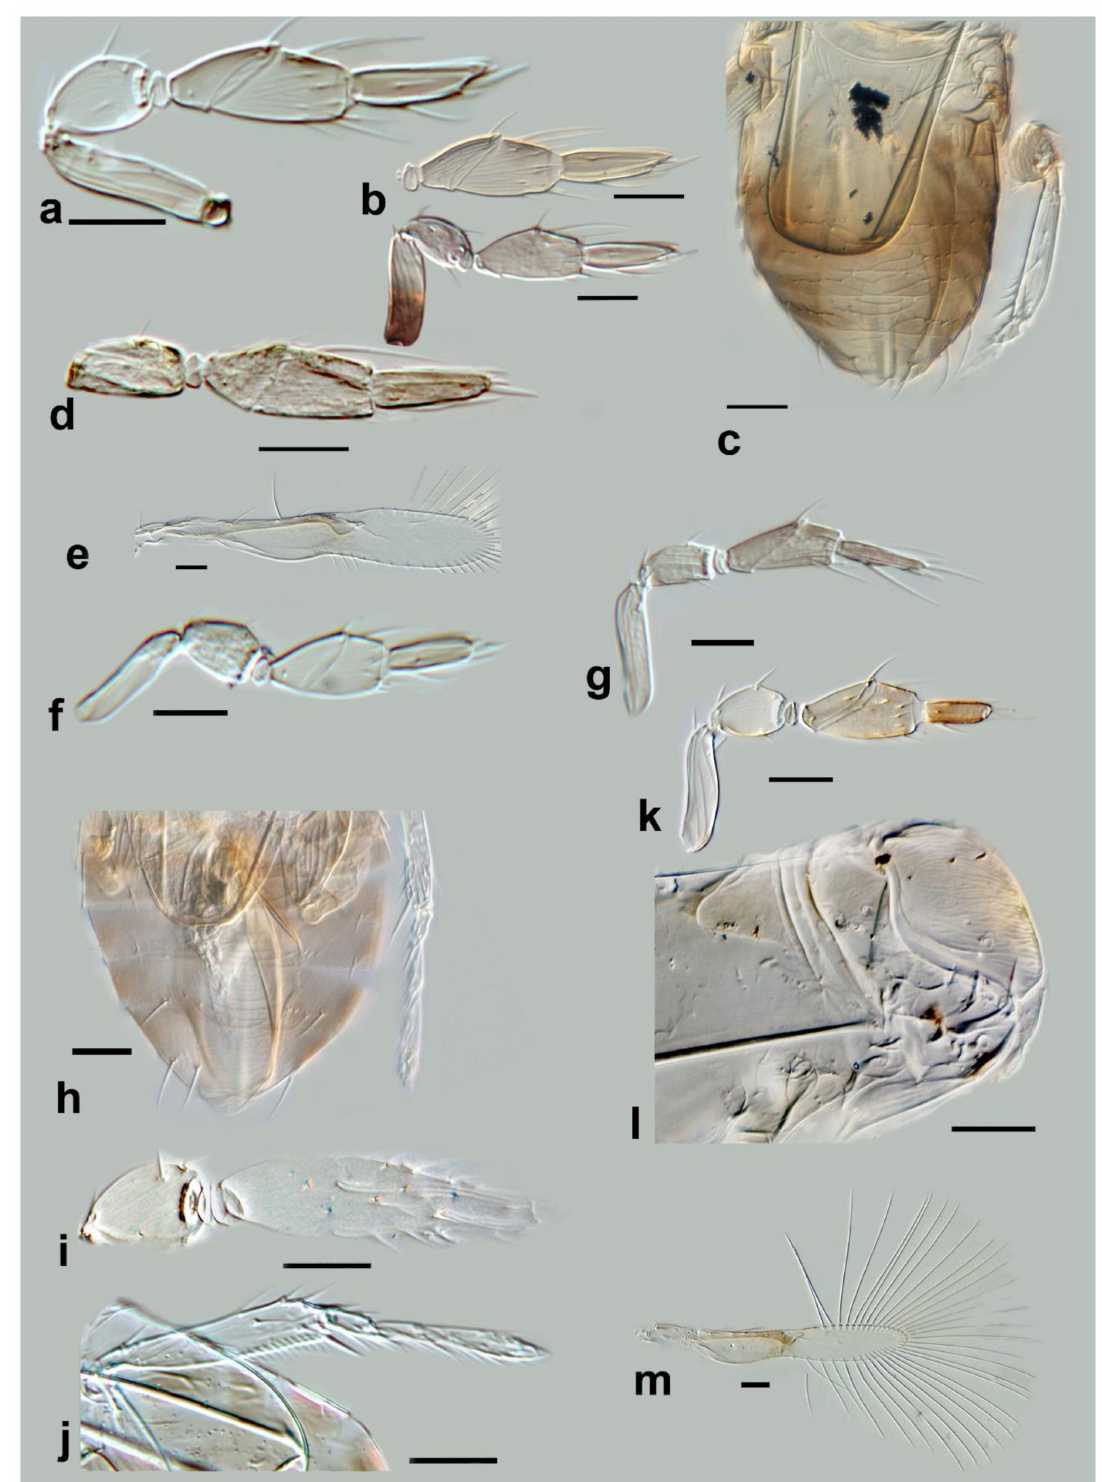
Figure 21. Photographs of Megaphragma species: ( a ) M. rivelloi , female antenna (Holotype); ( b ) M. striatum , female antenna (MXM1 above and Paratype below); ( c ) M. striatum , female metasoma (MXM1); ( d ) M. tamoi , female antenna (Holotype); ( e ) M. tamoi , female fore wing (Holotype); ( f ) M. tridens , female antenna (Holotype); ( g ) M. tridens , male antenna (Paratype); ( h ) M. tridens , female metasoma (Holotype); ( i ) M. uniclavum , female antenna (Holotype); ( j ) M. uniclavum , female metatibia (Holotype); ( k ) M. vanlentereni , female antenna (Holotype); ( l ) M. vanlentereni , female mesosoma (Holotype); ( m ) M. vanlentereni , female fore wing (Holotype). Scale bars 20 µ